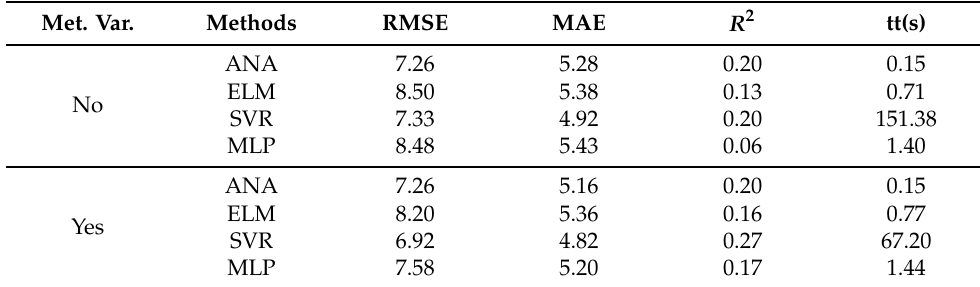
Table 6. Performance of the evaluated ML regression methods in the prediction problem on the school absences